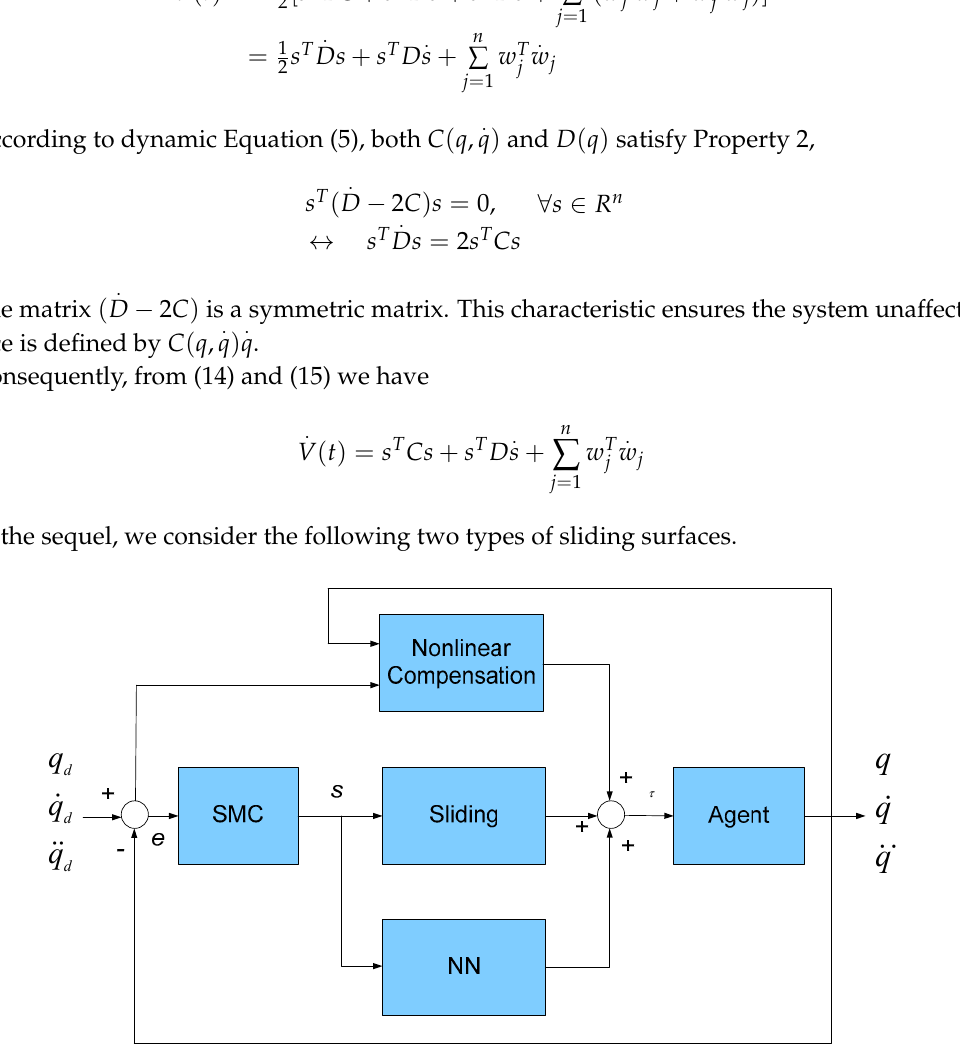
Figure 1. The controller structure with nonlinear compensation Neural Network (NN).